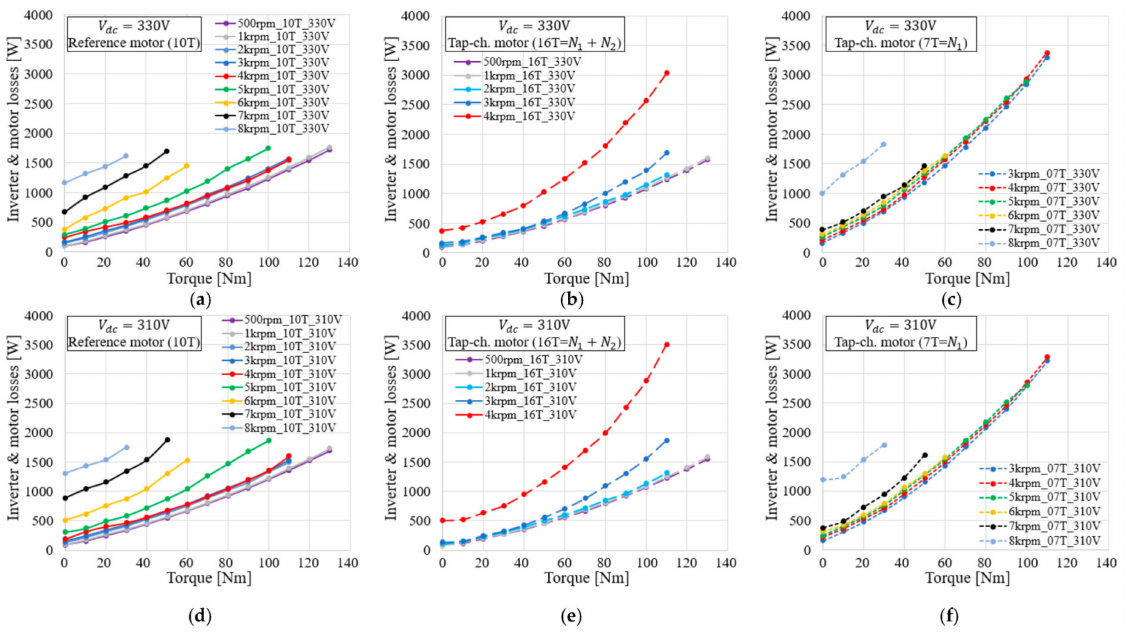
Figure 10. Experimental results of the inverter and motor losses with the ( a ) reference motor, ( b ) low-speed mode of the tap-change motor, ( c ) high-speed mode of the tap-change motor with V dc = 330 V, ( d ) reference motor, ( e ) low-speed mode of the tap-change motor, ( f ) high-speed mode of the tap-change motor with V dc = 310 V.